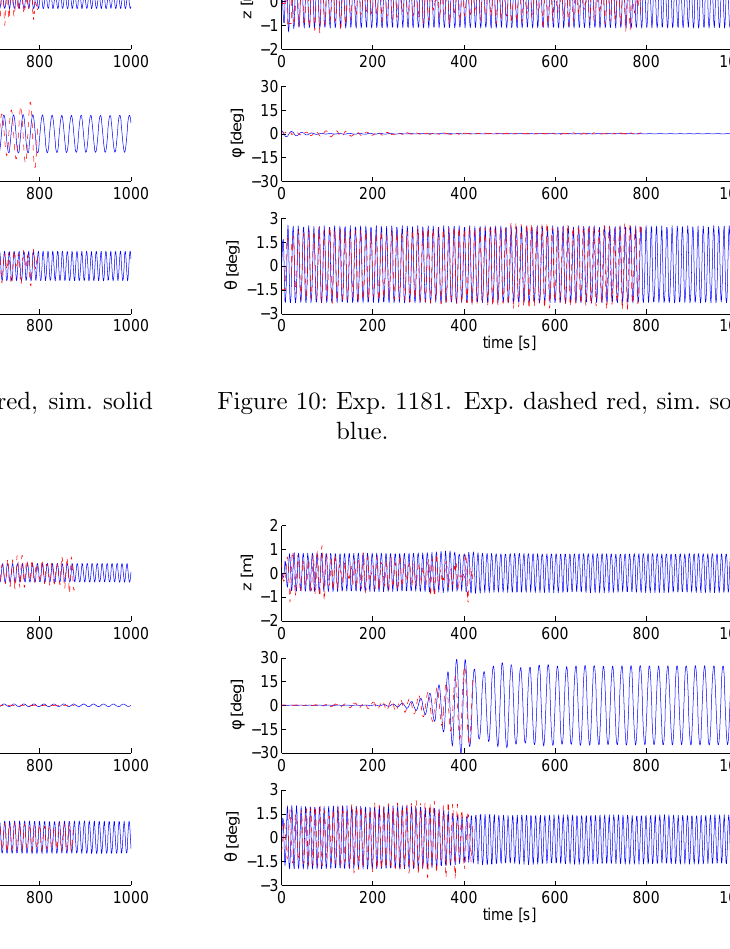
Figure 11: Exp. 1179. Exp. dashed red, sim. solid blue.